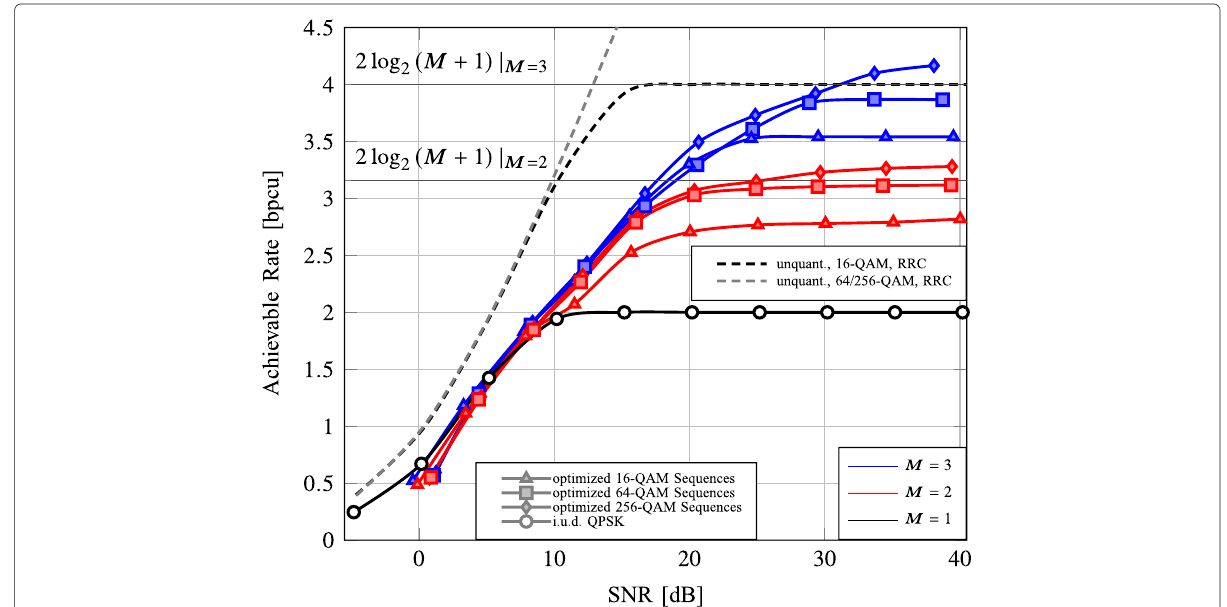
Fig. 11 Achievable rate for different oversampling rates and QAM modulation orders; for comparison, upper bound on the achievable rate when using M comparators in a flash ADC with the same number of comparator operations per time interval (horizontal